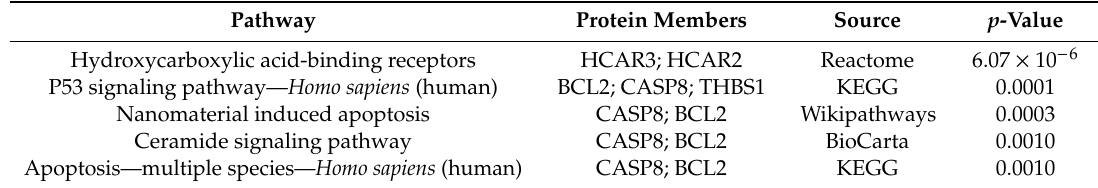
Table 3. Top five biologic pathways populated by a CPDB over-representation analysis of miRNA-1827.